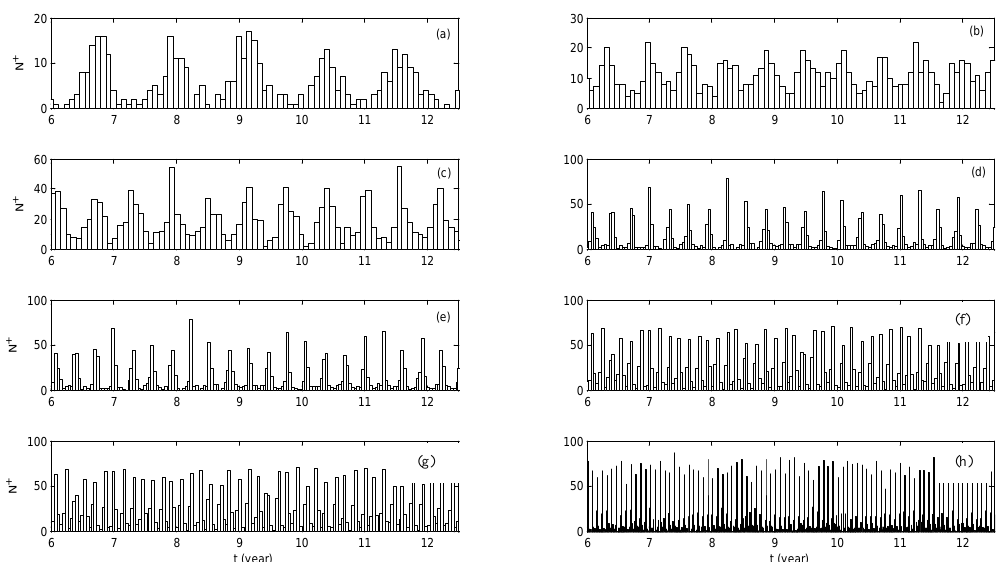
Figure 9. Synchronization/locking events off California. (a, c, e, h) The first quartets among the quasi-zonal jets, annual Rossby waves, semi- annual Rossby (SARWs) waves and mesoscale eddies from the fifth band. (b, d, g, f) The second quartets formed by biannual oscillations, SARWs and mesoscale eddies from the fifth and six spectral bands. N + is a number of synchronized